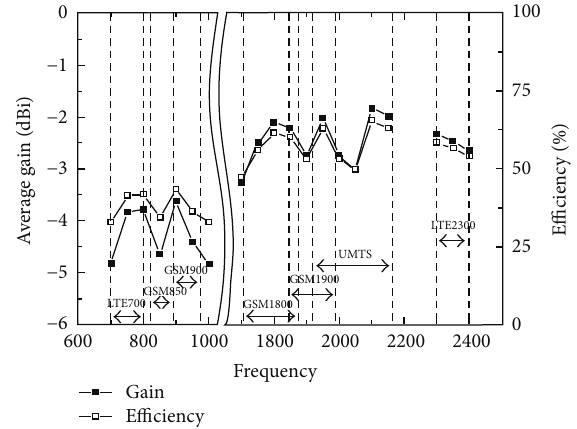
F 11: Measured average gain and efficiency of the proposed